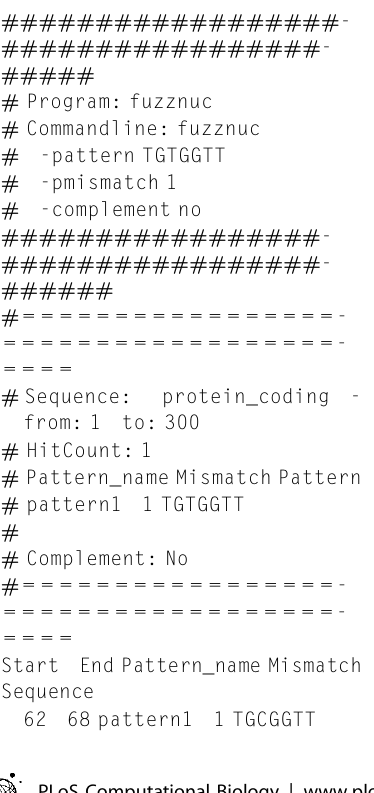
Figure 4. Screenshot displaying BioMart embedded in the Galaxy framework. select: GetData 4 BioMart (Central Server) to query the ‘Ensembl genes’ database and retrieve 300 bp upstream ( Attributes 4 Sequences 4 Flank-coding region ) to ENSG00000100985. Following this, we can run fuzznuc (from EMBOSS) to find out if the Runx2 motif is upstream of the human gene. Such short motifs (length , 10) cannot be identified by BLAST, SSAHA, or BLAT; that’s why we will use EMBOSS.